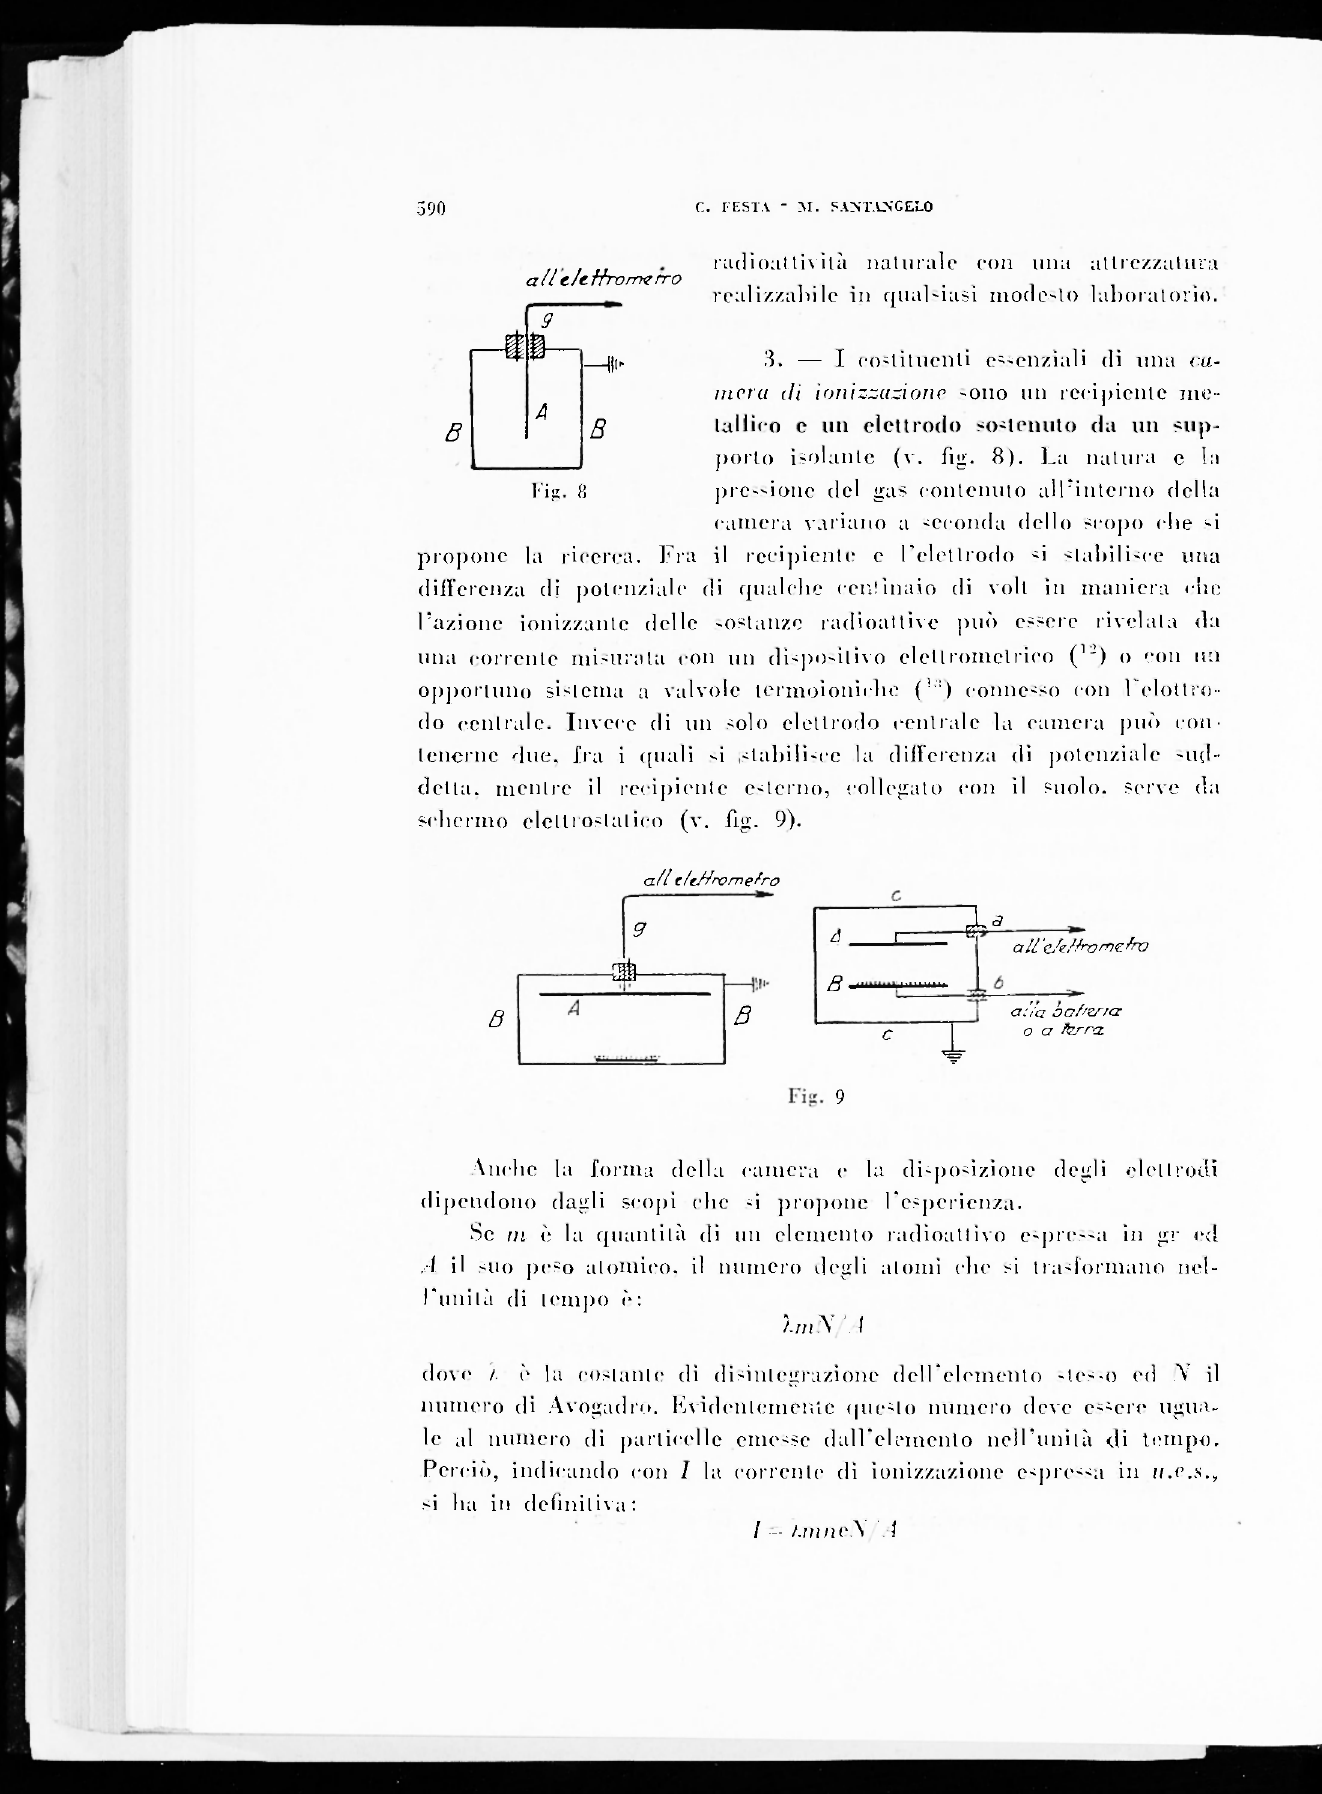
Fig. 8 pressione del gas contenuto all'interno della camera variano a seconda dello scopo che